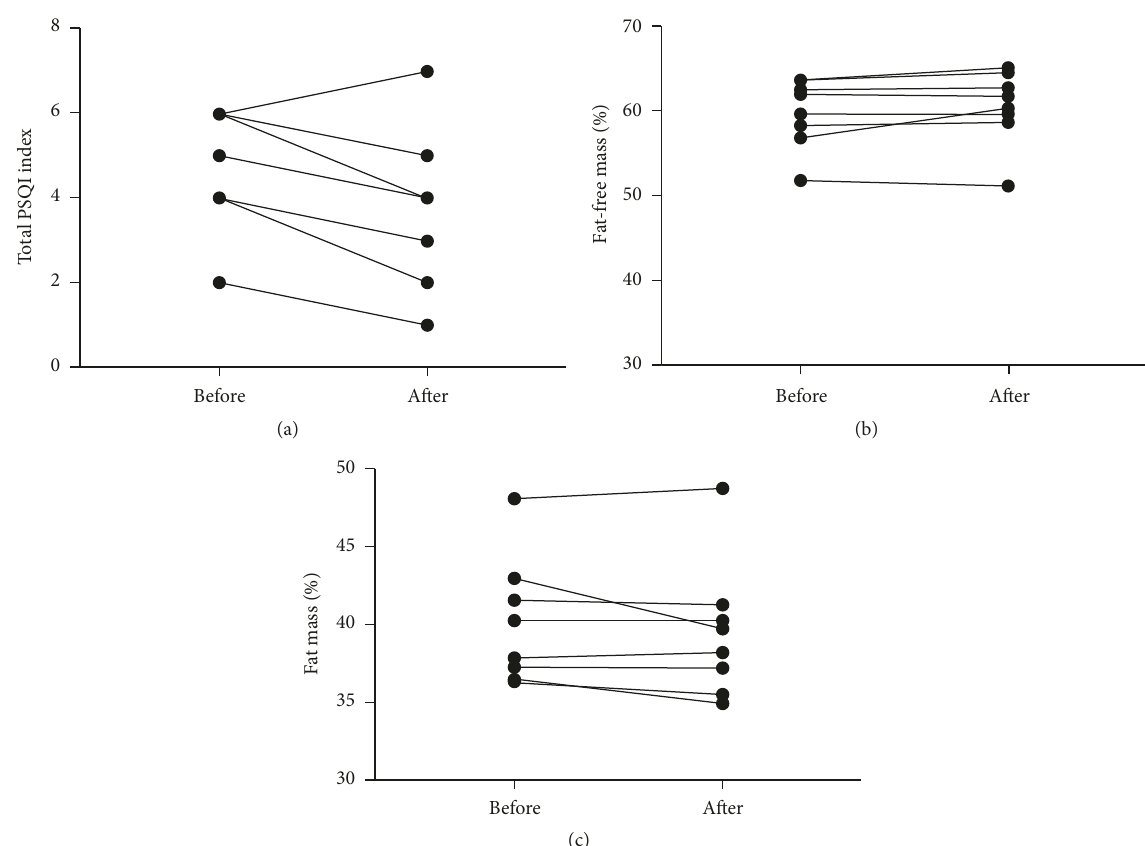
Figure 1: Changes in quality of sleep (a), fat-free mass (%) (b), and fat mass (%) (c) for each elderly woman before (in baseline) and after 8 weeks of a dynamic combined training